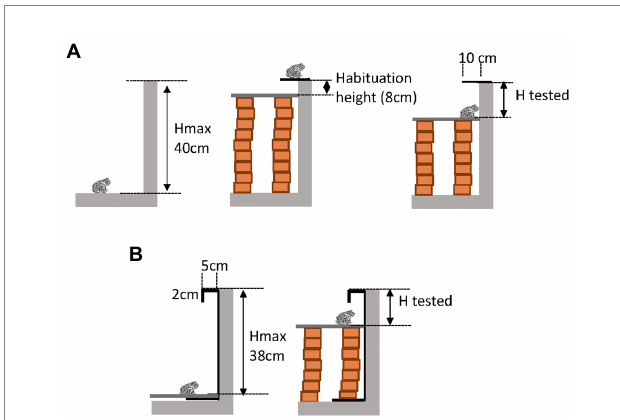
FIGURE 3 Setup to test the capacity of amphibians to cross different fence types and heights. We used wooden blocks to adjust the concrete base to the desired fence height to be tested. All tests with adult amphibians started with a habituation height of 8 cm, before height was increased in the following trials. (A) Concrete fence tests: Hmax (the maximal height tested) was 40 cm, without or with an overhang of 10 cm; (B) galvanized metal fence tests: Hmax was 38 cm; this fence type had a bent overhang (5 cm horizontal +2 cm